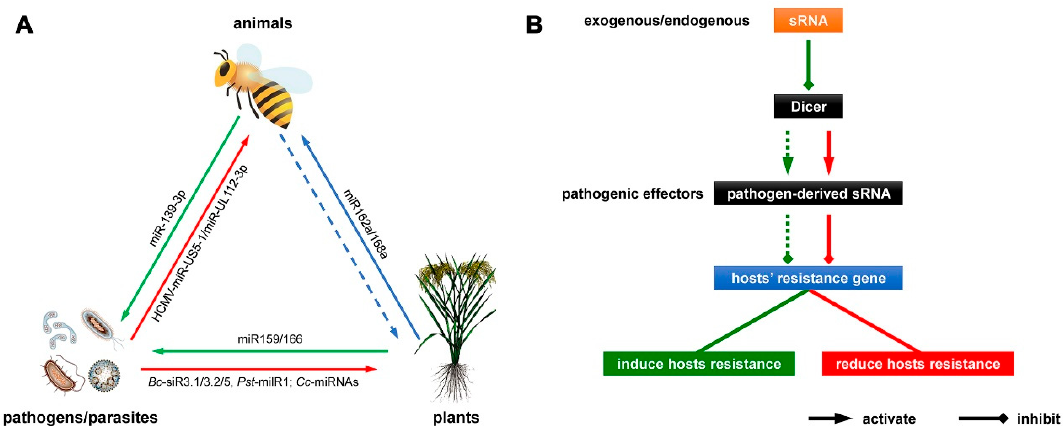
Figure 1. ( A ) The model of miRNA-mediated cross-kingdom regulation. The blue arrow indicates that plant miRNAs (e.g., miR162a and miR168a) regulate gene expression in animals. The blue dotted arrow indicates that no relevant experiment has been reported up to this time. The red and green arrows stand for the model of miRNA-mediated cross-kingdom regulation in pathogen/parasite–host interactions, which indicate that pathogen/parasite miRNAs (e.g., Bc -siR3.1/3.2/5, Pst -milR1, Cc-miRNAs and HCMV-miR-US5-1/miR-UL112-3p) regulate gene expression in hosts, and host miRNAs (e.g., miR159/166 and miR-139-3p) regulate gene expression in pathogens, respectively; ( B ) New insights into the diagnosis and control of pathogenic diseases. Lines of the same color stand for location on the same pathway. Dotted lines stand for reductions in the positive or negative effects.